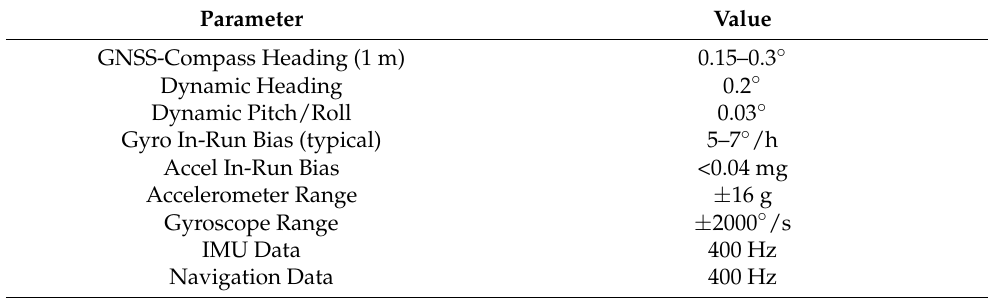
Table 1. Basic functions and parameters of dual-antenna GNSS/INS sensor VN-300 from Vectornav [70].